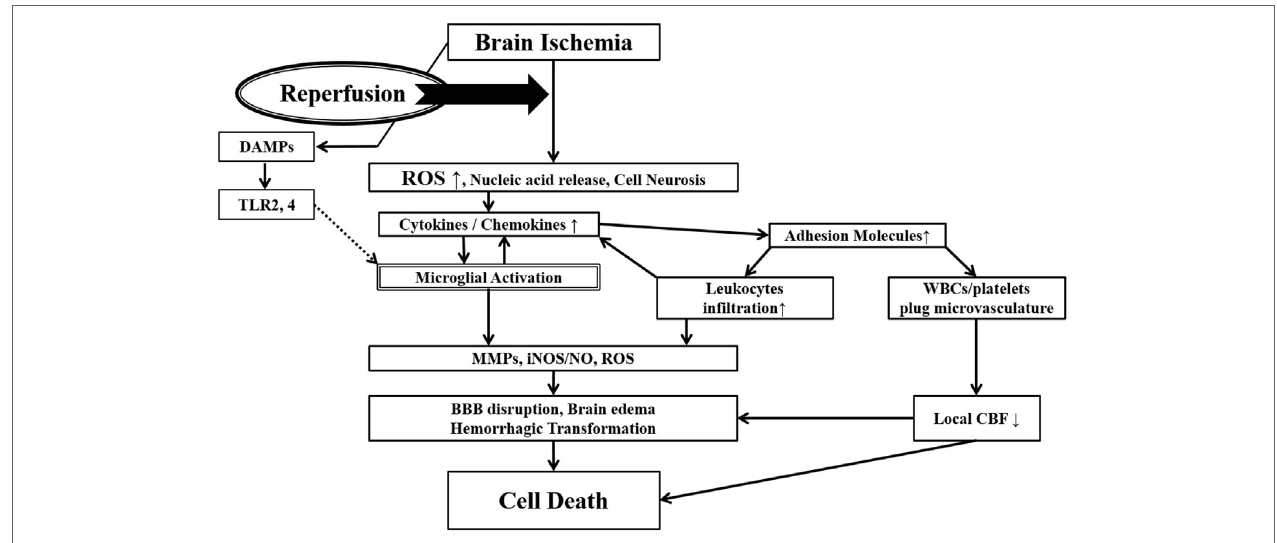
FigURe 1 | Ischemia-induced inflammation in association with reperfusion injury. Once brain ischemia occurs, oxygen and glucose supplies are reduced. If ischemia occurs for more than a certain time period (likely a few hours, but the precise duration is not well established) and blood flow is restored (reperfusion), worsened injury can paradoxically occur to the brain. This is often referred to as reperfusion injury. A major component of reperfusion injury involves subsequent inflammatory reactions induced through various mechanisms. Reperfusion leads to the introduction of ROS from oxygenated blood and can stimulate an immune response in the ischemic brain. Necrotic, ischemia-injured cells lyse and release their contents into the extracelluar space which can act as ligands for various immune receptors. Among these include nucleic acids which are one of many described damage-associated molecular pattern (DAMPs, see text for details). DAMPs can then bind TLRs and stimulate several inflammatory responses (microglial activation, overexpression of proinflammatory cytokines, chemokines) which lead to worsened brain injury. Inflammatory signaling also causes immune cells to generate more effector molecules such as ROS and iNOS/NO. In the periphery, cytokines and adhesion molecules can attract circulating immune cells to the ischemic brain where they infiltrate the damaged tissue and further amplify ischemic injury. Some circulating immune cells and platelets can also plug the microvasculature of the ischemic brain and cause secondary reductions in local CBF. In addition to brain cells, these inflammatory reactions can also cause damage to brain endothelia causing BBB disruption, edema and hemorrhagic transformation. Thus, the restoration of CBF can cause more extensive brain tissue damage. This vicious cycle is often called reperfusion injury. ROS, reactive oxygen species; DAMPs, damage-associated molecular patterns; TLR, toll-like receptor; MMPs, matrix metalloproteinases; iNOS, inducible nitric oxide synthase; NO, nitric oxide; BBB, blood–brain barrier; CBF, cerebral blood